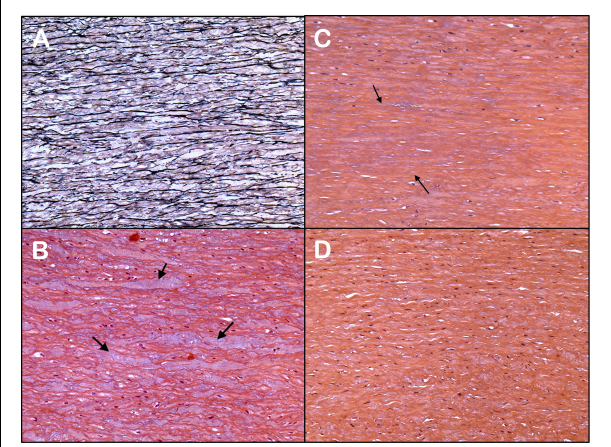
FIGURE 1 | Different histological features observed in aortas of BAV patients (A–C) and the normal aorta (D) : (A) Fragmentation and loss of the elastin fibers (limited to 1 or 2 lamellar units; mild grade) (Elastic stain; Original X10). (B) Inter-lamellar degeneration with mucoid replacement (MEMA) (H&E stain; Original X10). (C) Moderate loss of nuclei of vascular smooth muscle cells (involving 4 to 10 lamellar units; area between arrows) (H&E stain; Original X10). (D) Normal ascending thoracic aorta. The media shows no mucoid accumulation in the extracellular matrix or loss of smooth muscle cells (H&E stain; Original